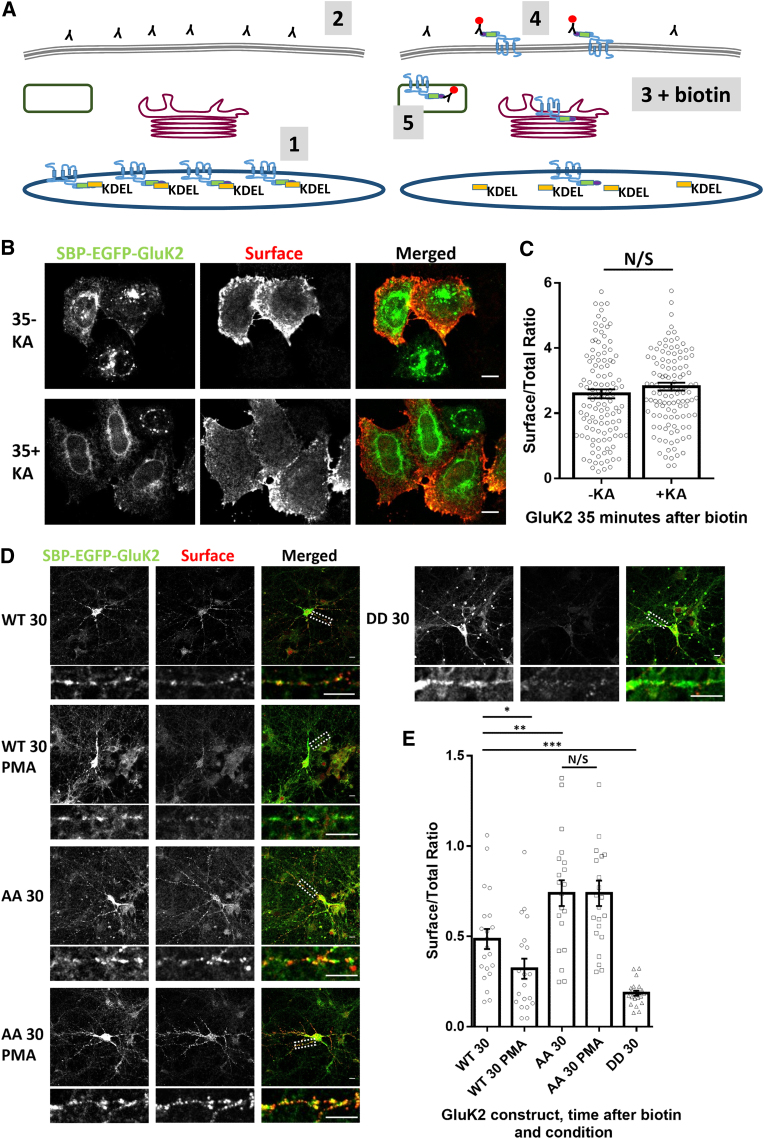
Basal PKC Phosphorylation Suppresses Surface Delivery of KARs(A) Schematic illustrating the live labeling protocol used to exclude any contribution of changes in endocytosis. 1: hooked RUSH receptor before the addition of biotin. 2: live label with anti-SBP antibody. 3: addition of biotin allows release of receptors and accumulation at the cell surface. 4: anti-SBP antibodies bind to newly exposed SBP-tagged receptors. 5: a proportion of receptors internalize, but cells are permeabilized and labeled with a secondary antibody labeling all receptors that have been surface-exposed.(B) Representative images of the live labeling protocol showing that 100 μM KA does not change the secretory pathway delivery and extent of surface expression of SBP-EGFP-GluK2 in HeLa cells 35 min after biotin addition. See also Figure S4A.(C) Quantification of the data shown in (B); two independent experiments, n = 80. p > 0.05, Welch’s t test.(D) Representative images of hippocampal neurons expressing SBP-EGFP-GluK2 WT, SBP-EGFP-GluK2 S846A/S868A, or SBP-EGFP-GluK2 S846D/S868D 30 min after biotin in the presence or absence of PMA. Total receptor distribution was measured using the EGFP tag, and surface-expressed receptors were determined using live labeling with anti-SBP. See also Figure S4B.(E) Quantification of three independent experiments (n = 17–22). ∗∗∗p < 0.0005, ∗∗p < 0.01, ∗p < 0.05; Welch’s t test.Scale bars, 10 μm.